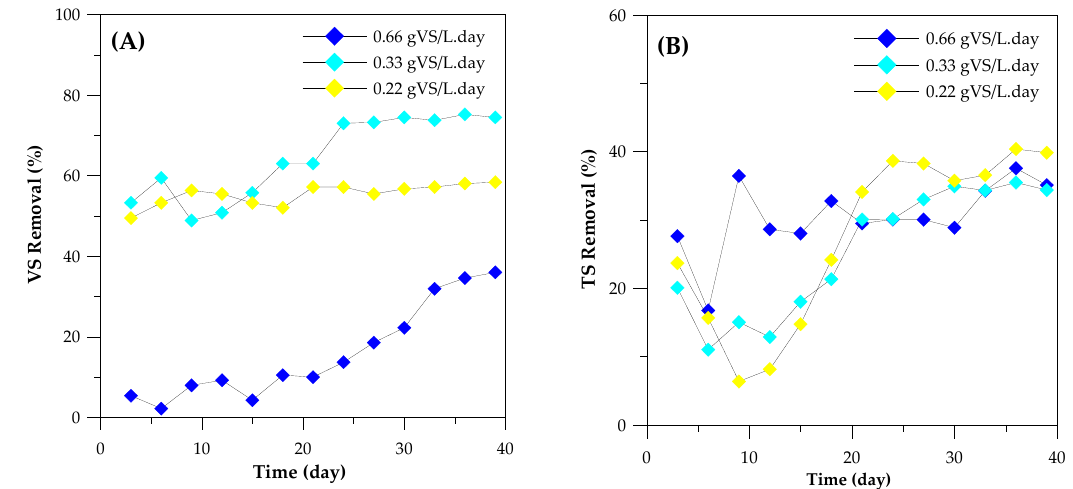
Figure 4. VS and TS performance of co-digestion of canteen food waste and domestic wastewater in a semi-continuous experiment, showing daily results for ( A ) VS removal and ( B ) TS removal.